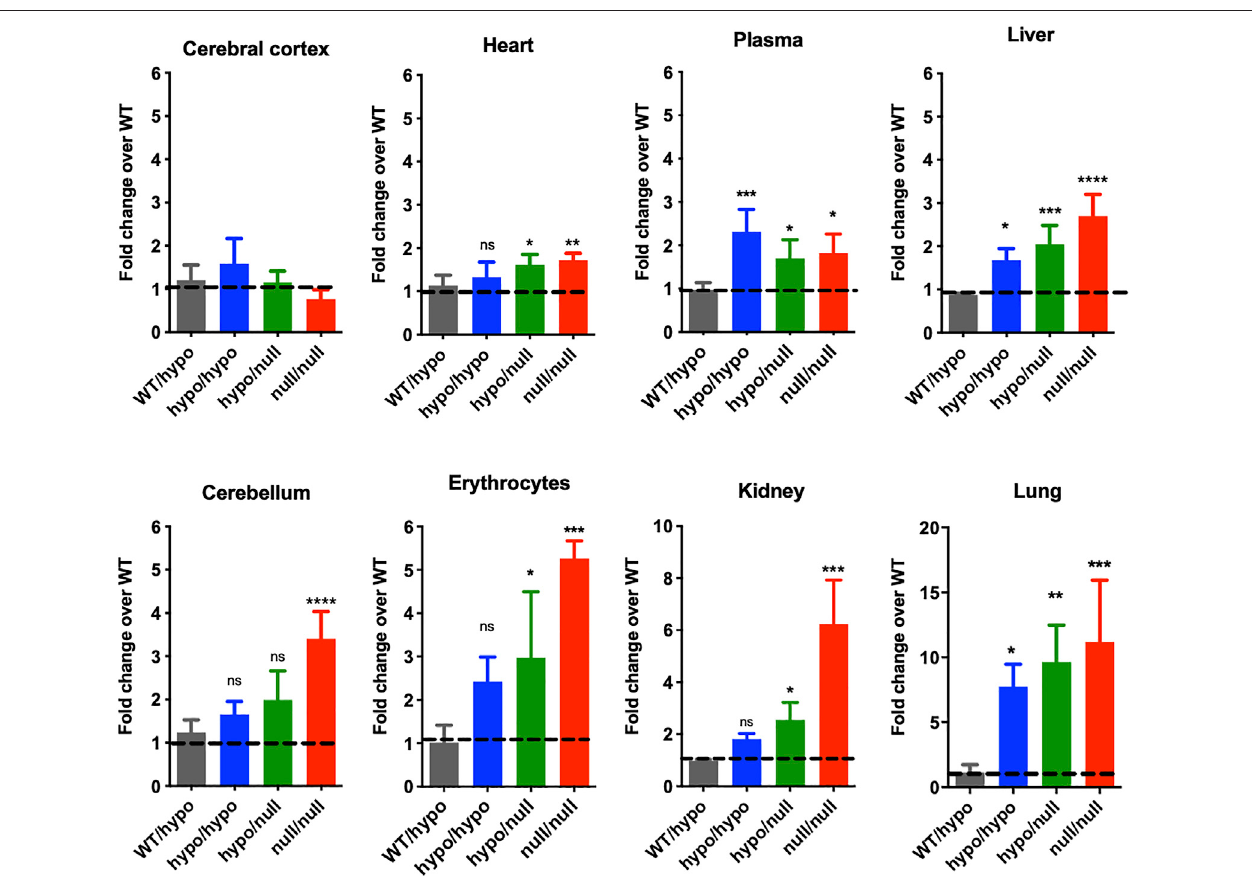
FIGURE5| Pex7 genotypecorrelateswithC26:0-LPC(VLCFA)levels.ElevationsinC26:0-LPCrepresentedasfoldchangeoverwild-type(WT)aredetectedinthe bloodandseveraltissuesof4-month-old Pex7 de fi cientmice.Nosigni fi cantincreaseinC26:0-LPClevelswasfoundinthecerebralcortexof Pex7 de fi cientmice( n =4 – 6 per genotype). The dotted line represents the C26:0-LPC levels in Pex7 WT/WT mice. ns: nonsigni fi cant, * p < 0.05, ** p < 0.01, *** p < 0.001, **** p < 0.0001.